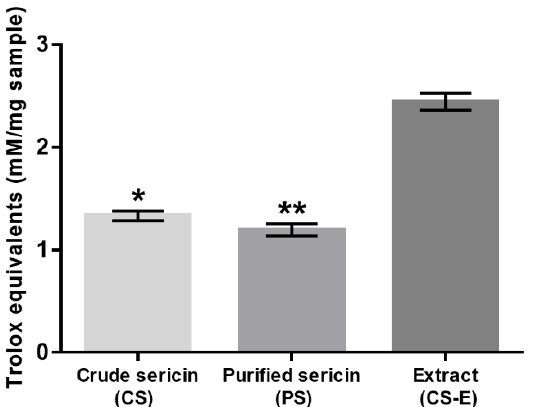
Figure 4. Antioxidant capacity of non-dialyzed (crude, CS) and dialyzed (purified, PS) sericin and of methanolic extract from crude sericin (CS-E) as determined by TEAC (ABTS +· ) assay and ex- pressed in Trolox equivalents. Bars represent mean values ± s. d. for n = 10. Statistical analysis was performed using the non-parametric Friedman test with Dunn’s multiple comparisons test. * p < 0.05; ** p < 0.0001. The difference between crude and purified sericins is not statistically significant ( p > 0.2).